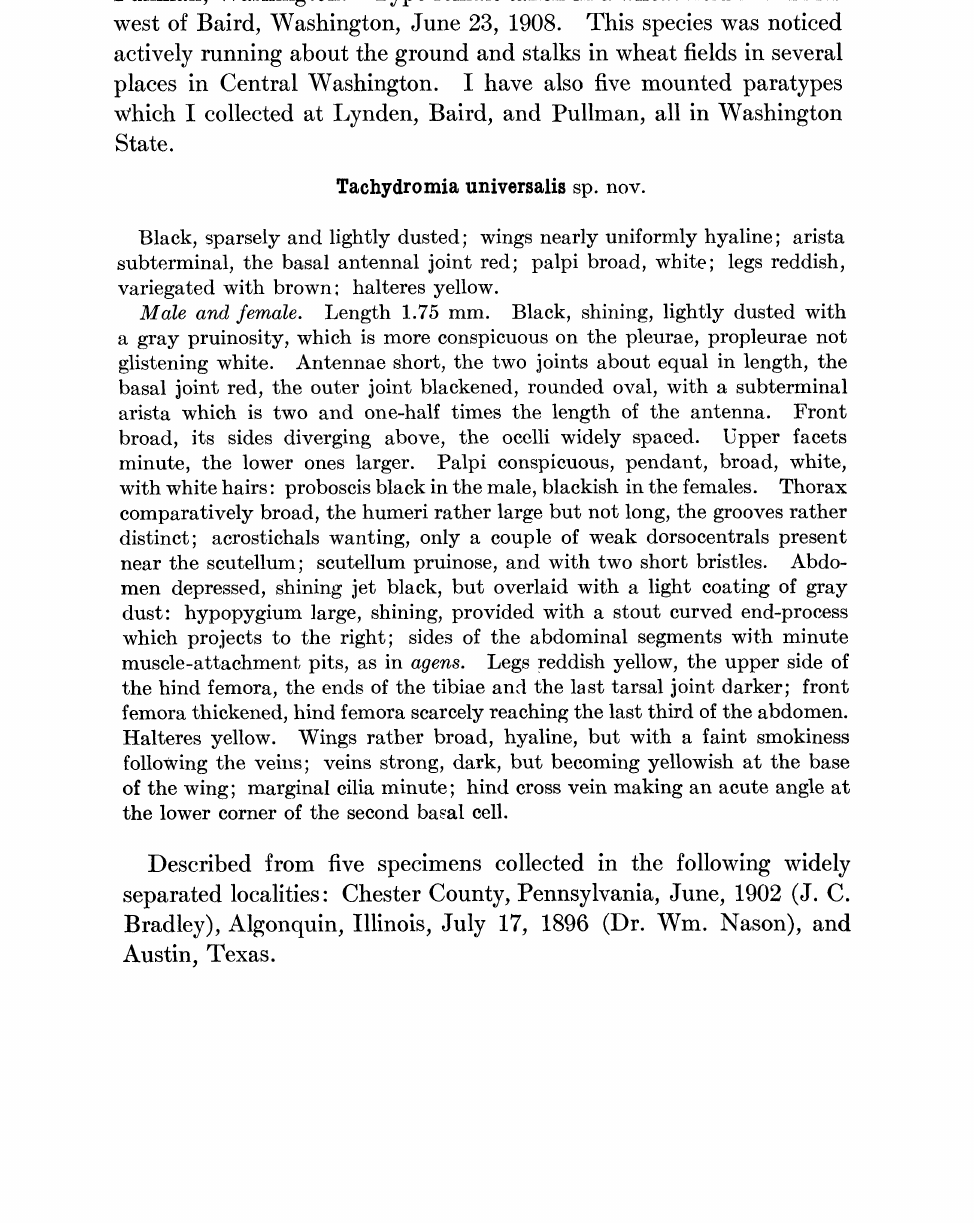
posterior ones pieeous, front eoxae fuscous and with white hairs; legs dark fuscous, with whitish pubescence, middle tibiae setulose beneath, front femora somewhat the thickest, reddish beneath. Halteres yellowish; tegulae with a few white cilia. Wings clear hyaline, veins strong, hind margin short ciliate, marginal cell long, third and fourth veins